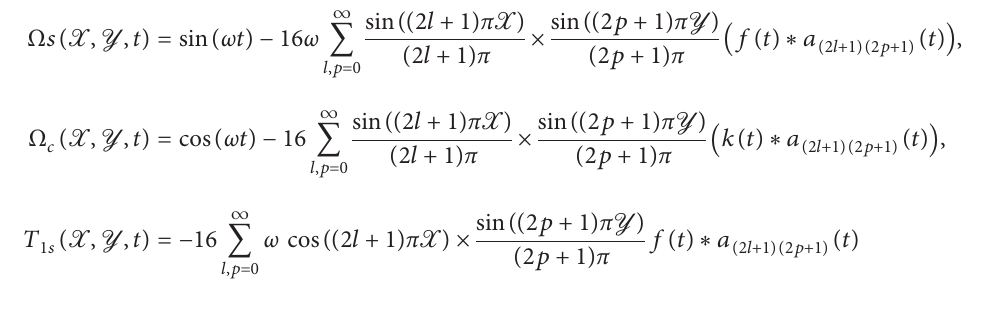
� 0 . 8, λ � 0 . 5, α � 0 . 8, c � 2, X � 0 . 45, and Y � 0 . 1 2